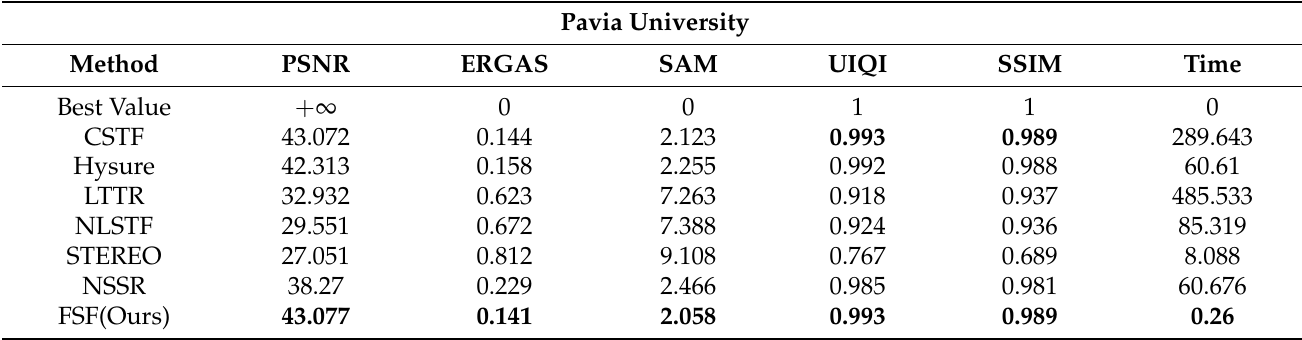
Table 3. The quantitative results of the experiment on the Pavia University dataset. The best results are shown in bold among all methods.